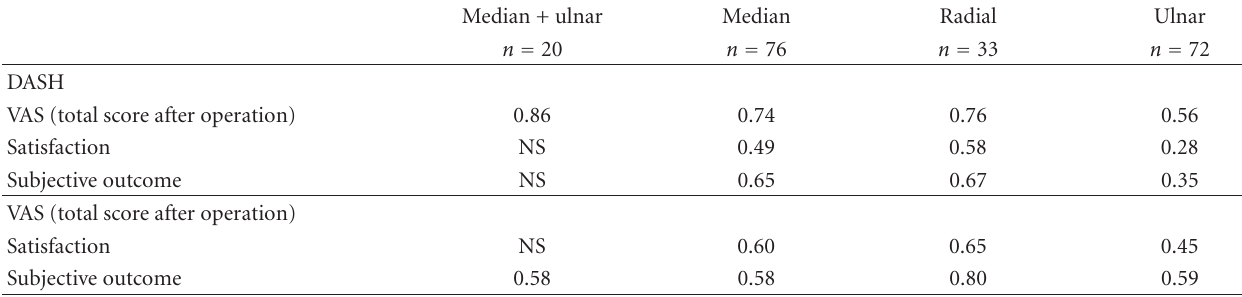
Table 3: Relationship between total pain score (VAS) and DASH, and factors related. All correlation coe ffi cients ( r ) are significant at P < 0 . 05.